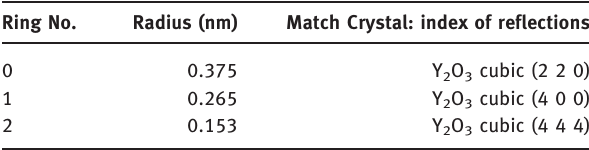
Table 1: Radius of rings from SAD pattern and possible matches for non Zr-ODS steel. Ring No. Radius (nm) Match Crystal: index of reflections